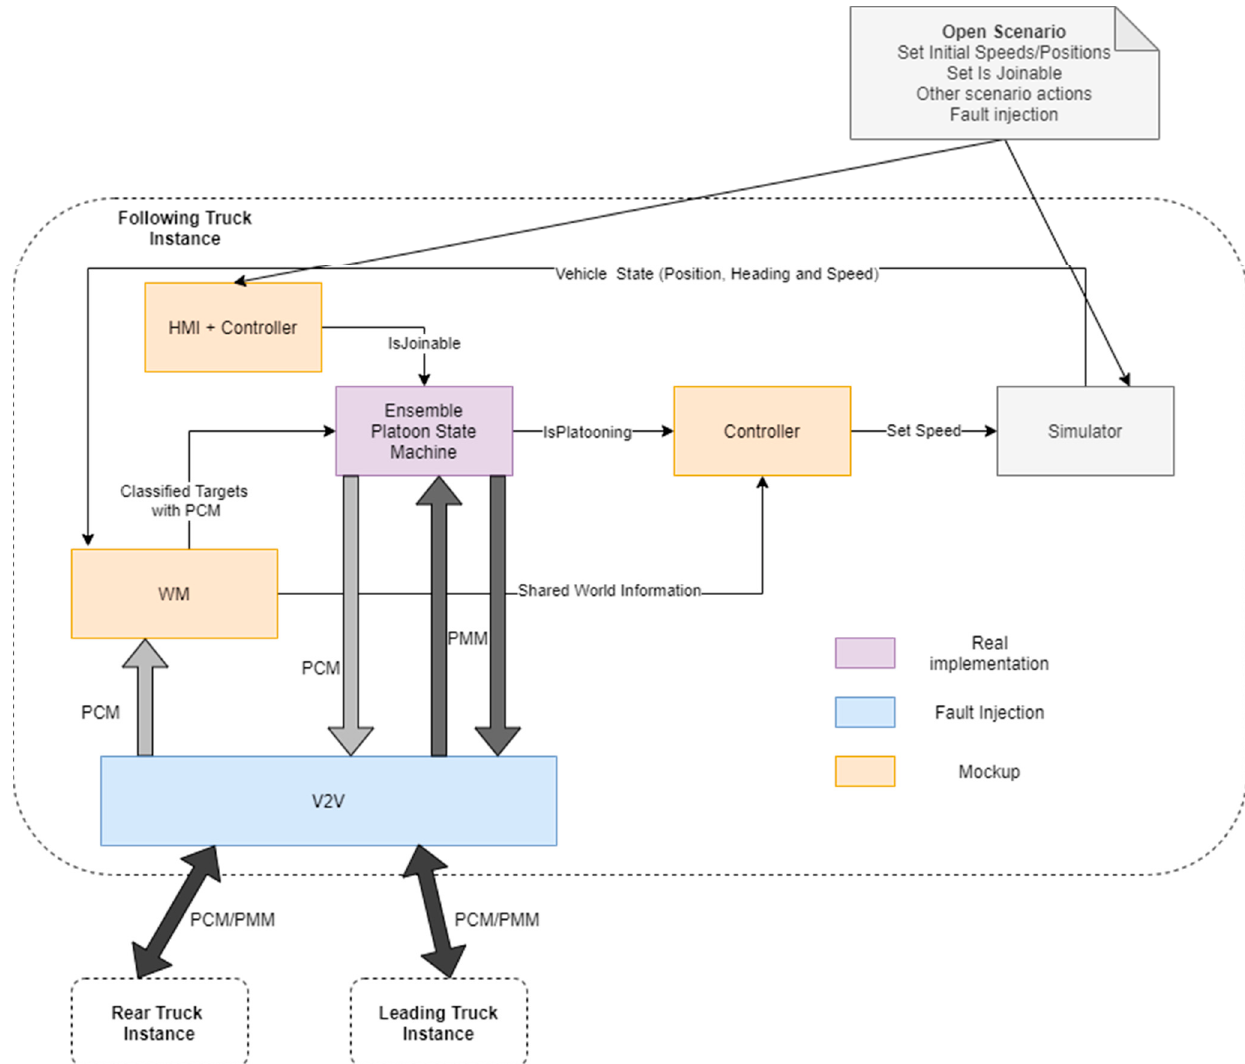
Figure 6. Truck platooning Hardware ‐ in ‐ the ‐ Loop (HiL) high ‐ level design .